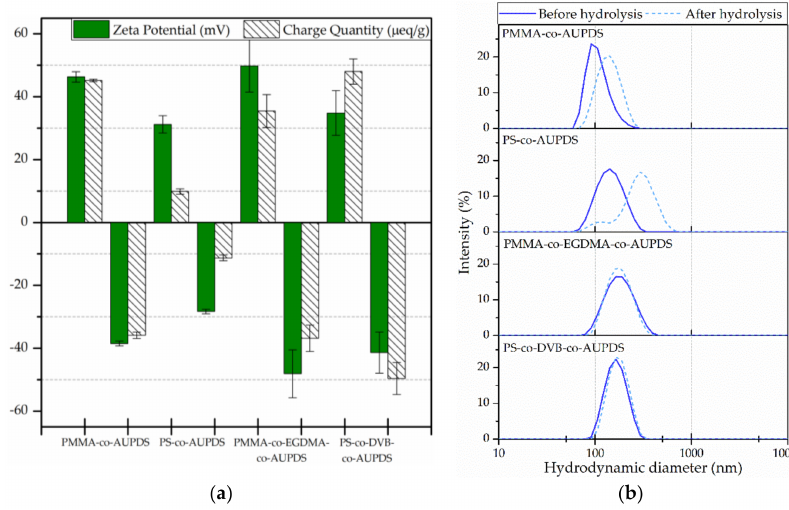
Figure 5. ( a ) Zeta potential and charge quantity distribution histograms obtained for non-cross-linked PMMA and PS NPs and cross-linked with 10 mol% cross-linker PMMA- co -EGDMA and PS- co -DVB NPs (all with AUPDS 2 mol%) through electrophoretic light scattering and polyelectrolyte titration. NPs were analysed before (unmodified) and after hydrolysis of the active ester group of AUPDS. The positive charge of the unmodified particles was titrated with PES and the negative charge of particles after hydrolysis was titrated using PDADMAC; and ( b ) hydrodynamic diameter distribution curves in terms of intensity (%) obtained via DLS analysis for the respective particles. DLS and PCD measurements were performed in sodium and potassium phosphate buffer (c = 5.2 mM, pH